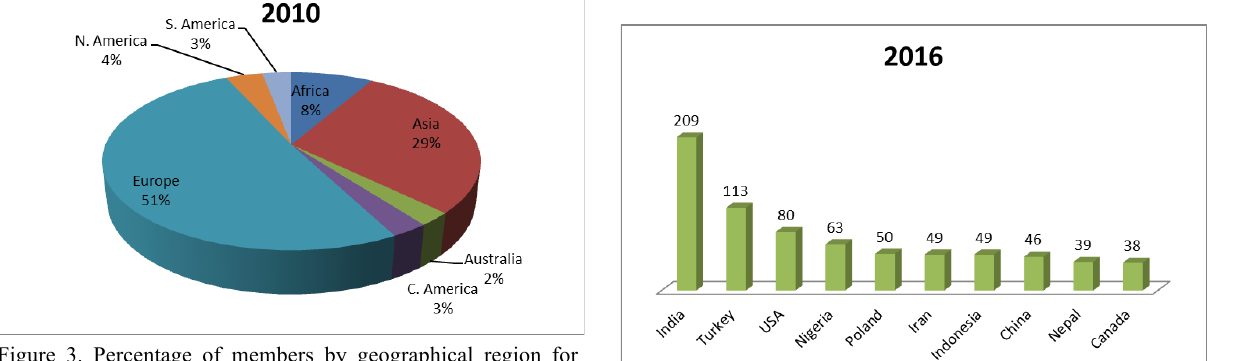
Figure 6. Top ten countries with the highest number of members in 2010 (Kivilcim et al., 2010).